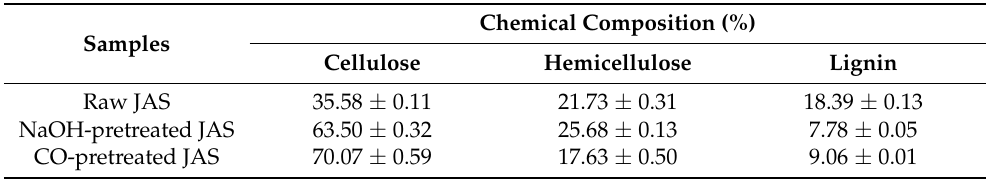
Table 2. Chemical composition of raw and pretreated